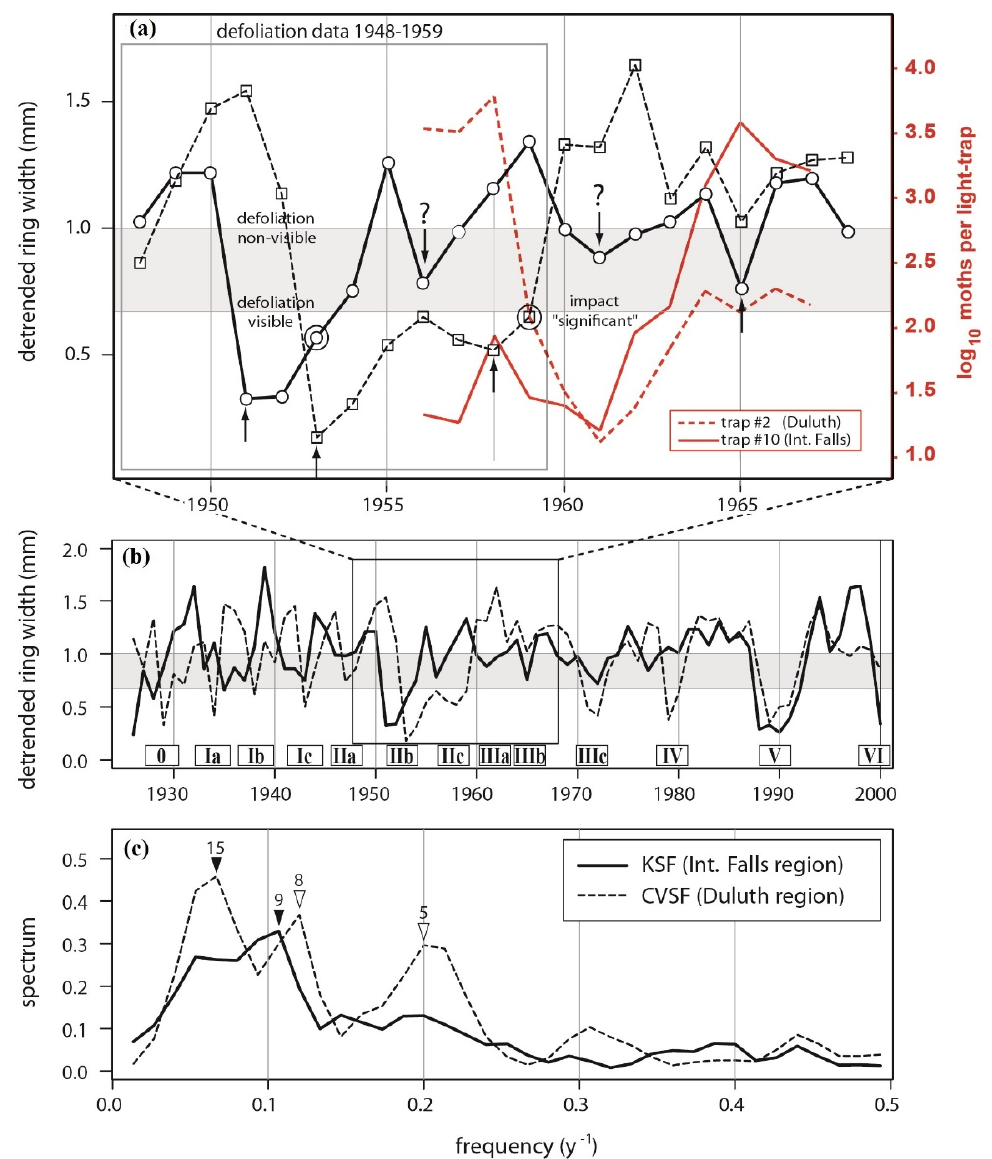
Figure 5. Cooke et al.’s (2003) detrended aspen ring width data. ( a ) Zoom on 1948–68 time-frame. ( b ) Full chronologies 1926–2000, with major outbreak cycles labelled with uppercase Roman numerals as per Figure 2, and ancillary pulses labelled with lowercase Latin alphabet, a–c. ( c ) Spectral analysis of the two ring width chronologies. Circled values in ( a ) indicate the last year in which defoliation was visible and radial increment impact was “significant”: 1953 at KSF and 1959 at CVSF. Upward pointing arrows in ( a ) indicate major growth reductions associated with high FTC populations. Question marks in ( a ) indicate lesser growth reductions that were sustained but were not clearly associated with high FTC populations. Raw ring-width data in ( b ) are the inputs to OUTBREAK used to reconstruct outbreaks in Figure 6. Growth depression IIIb is associated with a peak in FTC moths trapped at International Falls in 1965 in Figure 4b, but does not rise to the level of a 2–5 year ‐ long reduction in growth exceeding 1.28 (or even 0.44) standard deviations in Figure 6a, which is the standard definition of “outbreak”, and is used in Figure 2e.